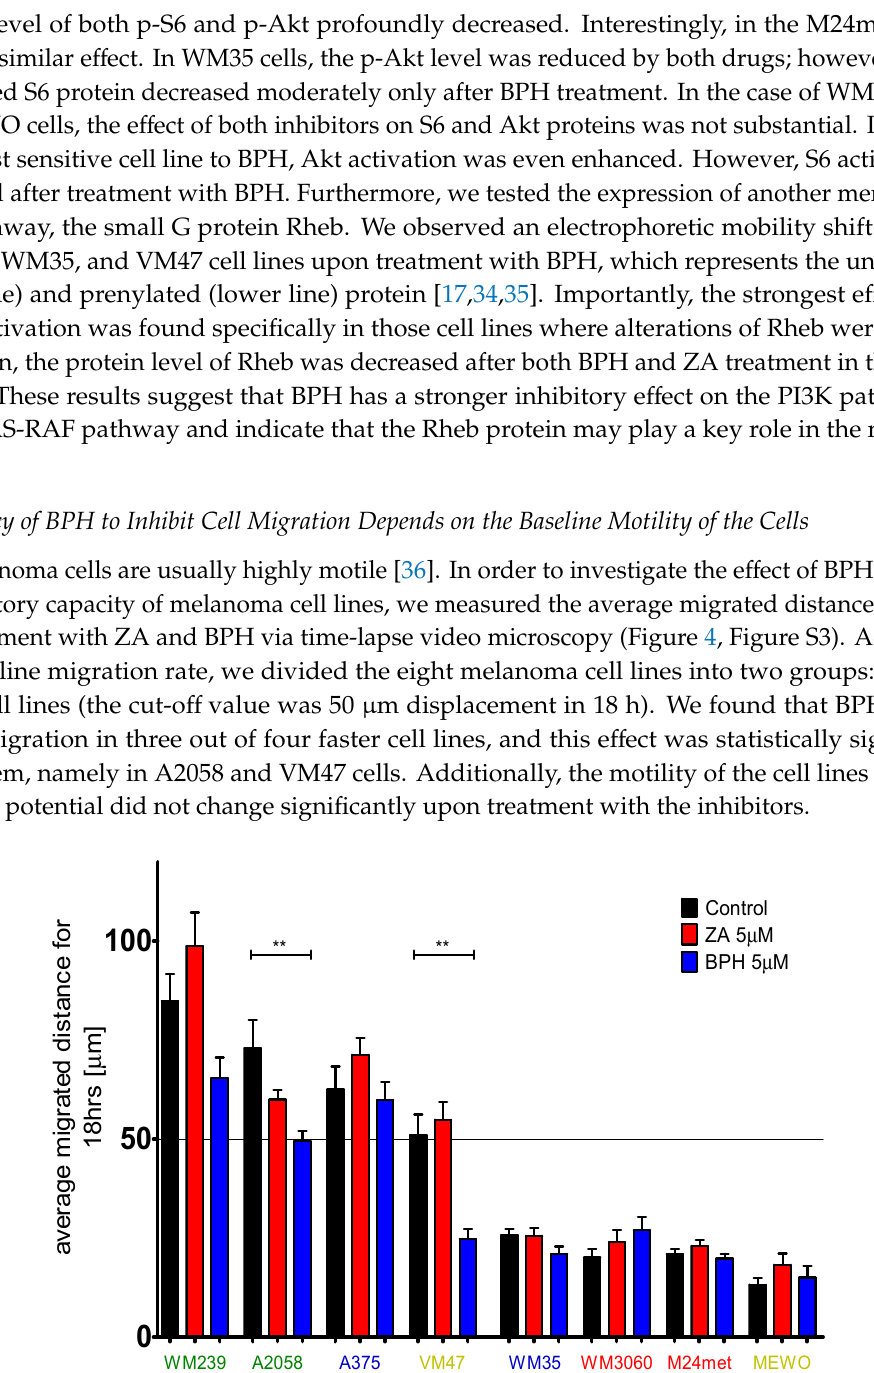
Figure 4. Average migrated distance of melanoma cell lines upon treatment with 5 µ M ZA or BPH was measured by time-lapse video microscopy. Cell lines were divided into two groups according to their baseline migratory capacity. The faster lines were more sensitive to the treatment with BPH than ZA. Moreover, ZA could cause an adverse effect on migration. Slower lines were insensitive to the treatment. Blue, green, red, and yellow colors indicate the mutation status of the cells, as the BRAF mutant, BRAF + PTEN mutant, NRAS mutant, and BRAF + PTEN + NRAS wild-type, respectively. Data are shown as the average of the migrated distance for 18 h ± SEM from at least two independent measurements and three non-overlapping microscopic fields. Asterisks mean a significant difference between control and BPH by ** p < 0.01.